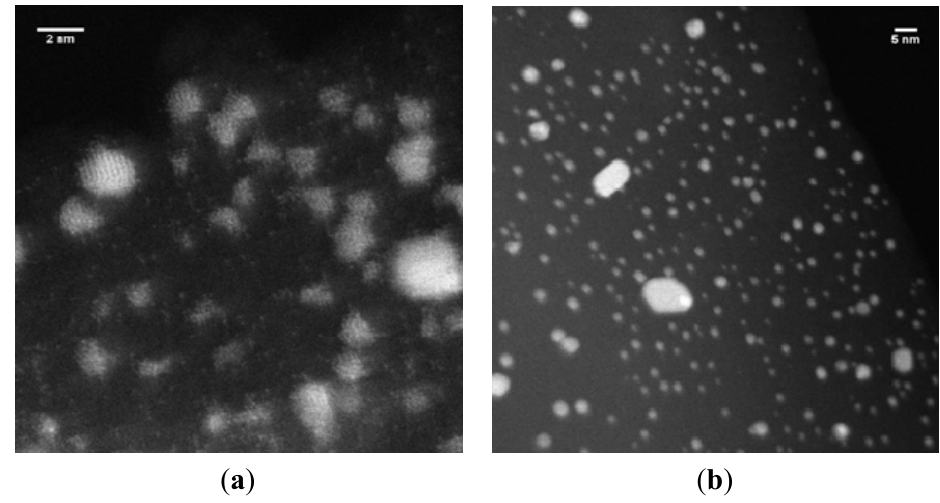
Figure 3. Au by magnetron sputtering on ( a ) AC and ( b )